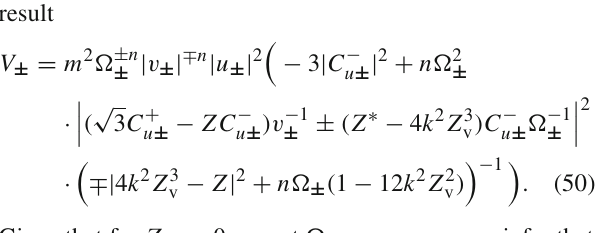
as a function P